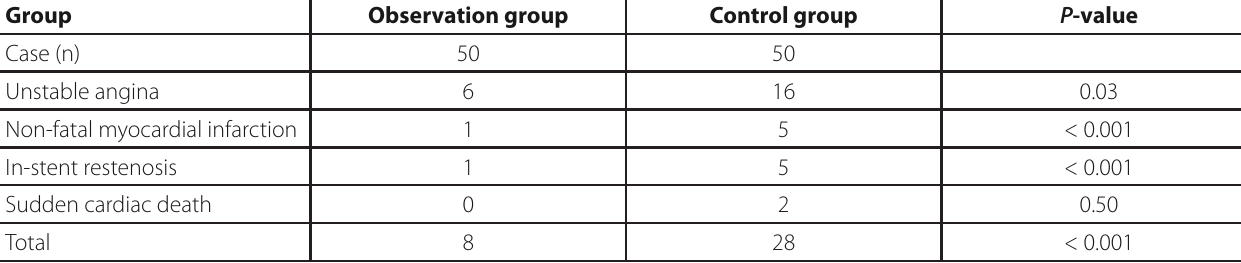
Table 4. Comparison of MACE between the two groups after continuing care.